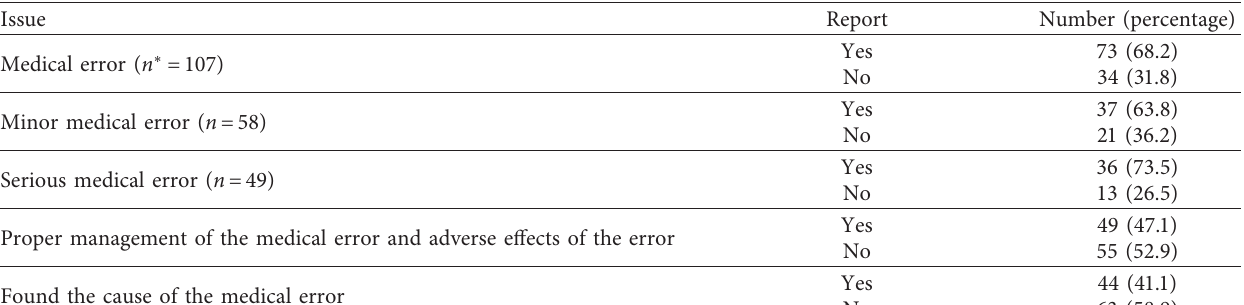
Table 4: The interns’ experience of medical error disclosure and management of the medical error.